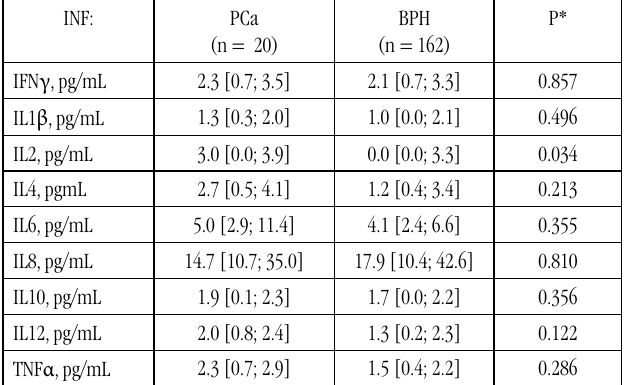
TABLE 3 - Circulating levels of immune mediators according to the diagnosis of prostate cancer (PCa) or benign prostatic hyperplasia (BPH)